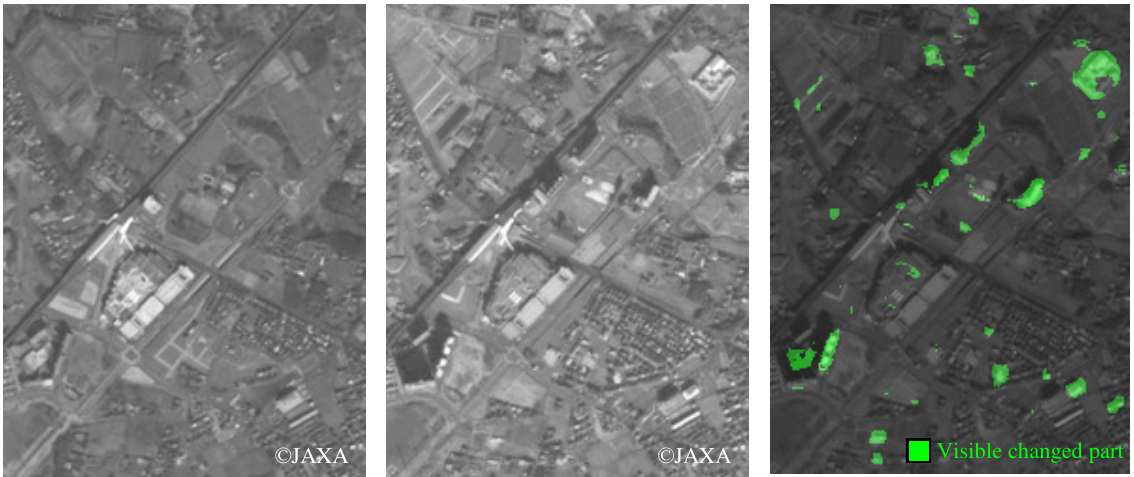
Figure 2: Example of pixel-change image Left: 1 st orthoimage, Center: 2 nd orthoimage, Right: pixel-change image overlayed with 2 nd orthoimage